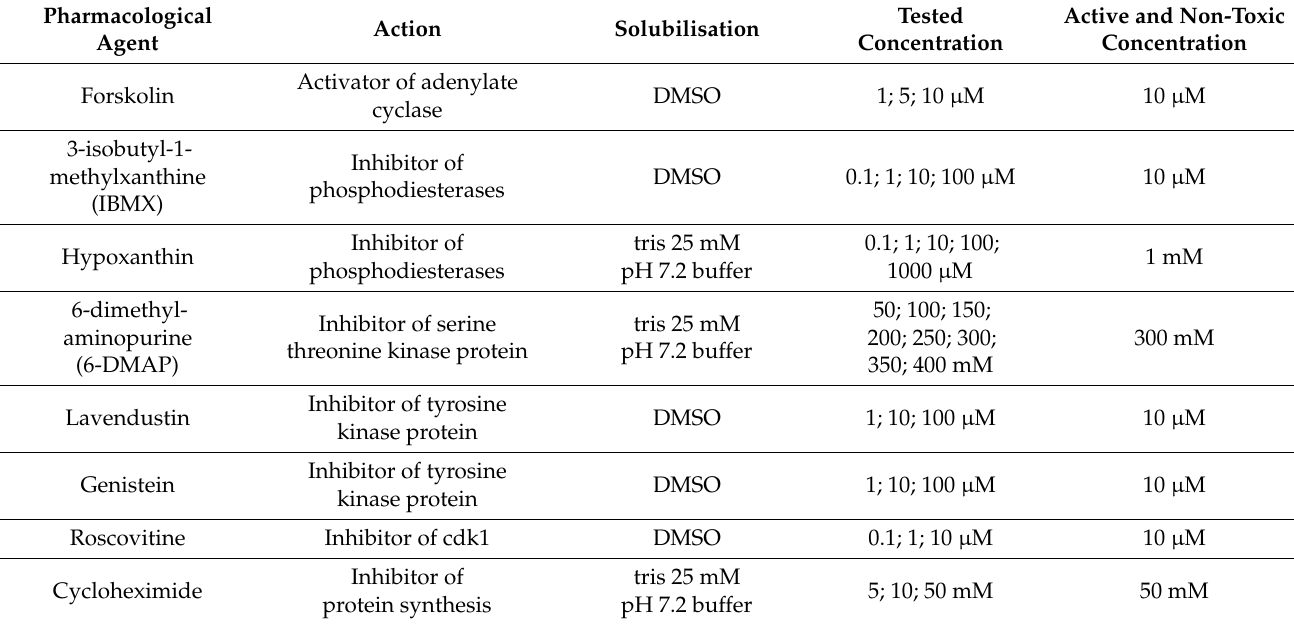
Table 1. Pharmacological agents with their specificity and their effect on oocytes maturation. All pharmacological agents were obtained at Sigma-Aldrich. Legend. DMSO: Dimethylsulfoxid. At higher concentrations the products became toxic for oocytes, or they were not soluble. The results presented in the present paper only show those obtained for the smallest active and non-toxic